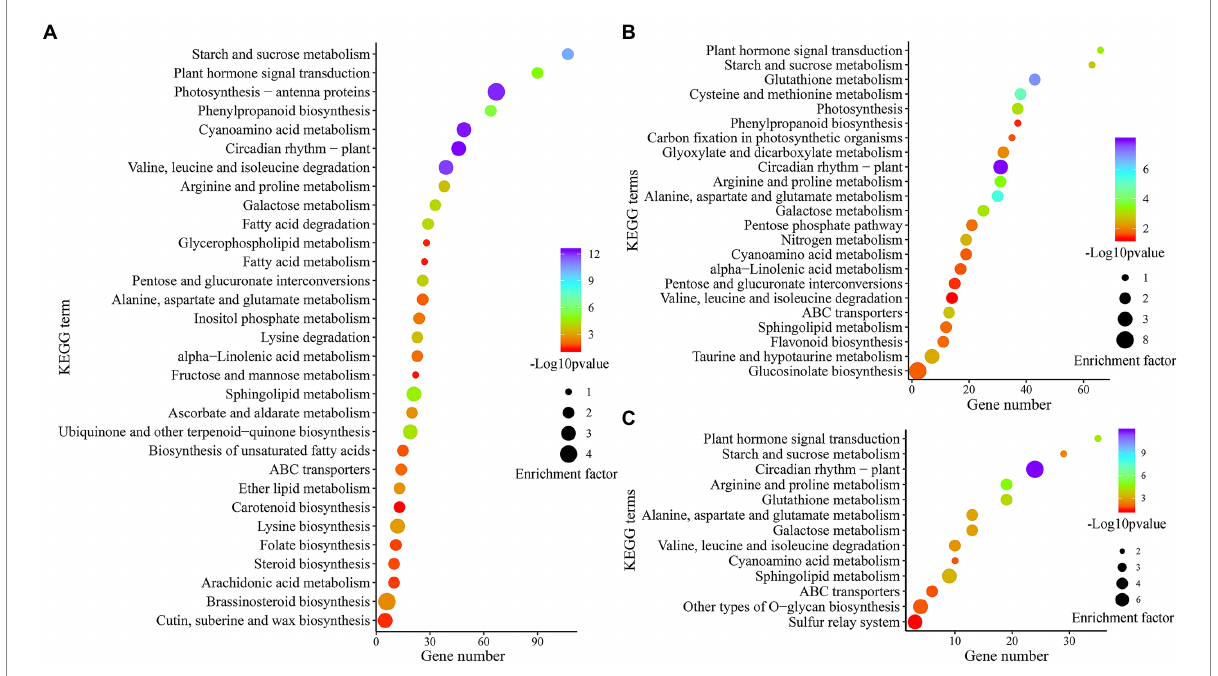
FIGURE 5 Scatter diagram of significantly ( p < 0.05) enriched KEGG pathways of DEGs in leaves (A) , roots (B) , and DEGs differentially induced in both tissues (C)